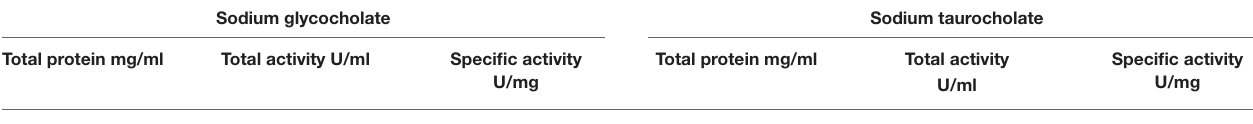
TABLE 4 | BSH activity of Enterococcus lactis YY1.